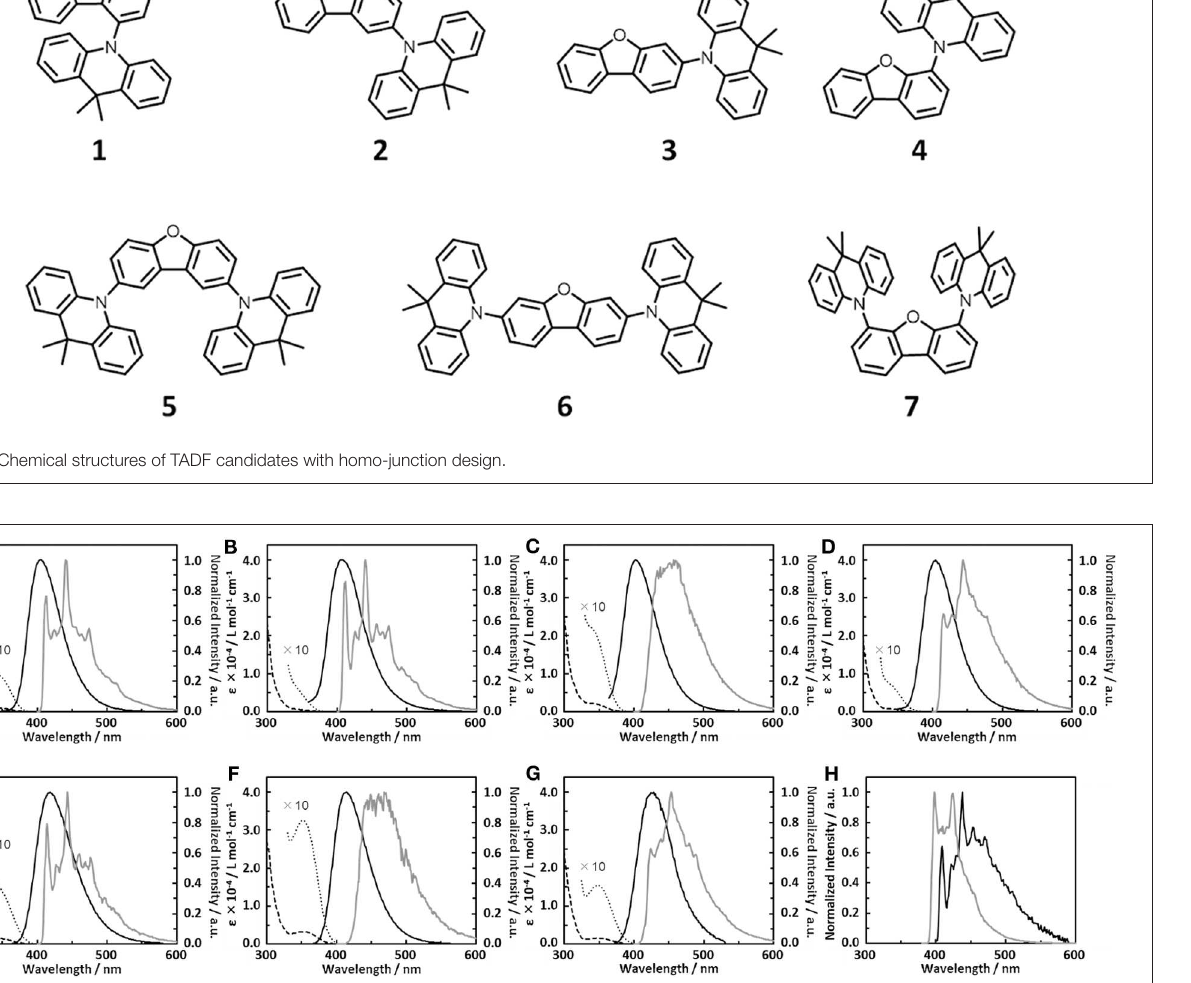
FIGURE 2 | (A–G) UV absorption (dashed line), fluorescence (solid black line) and phosphorescence (gray line) spectra of dimethylacridine-dibenzofurane combinations; (A) 1 , (B) 2 , (C) 3 , (D) 4 , (E) 5 , (F) 6 , (G) 7 ; 10 times enlarged absorption spectrum around 350nm (dotted line). (H) Phosphorescence spectra of dibenzofurane (black line) and 9,9-dimethyl-10-phenylacridine ( Ph-DMAc , gray